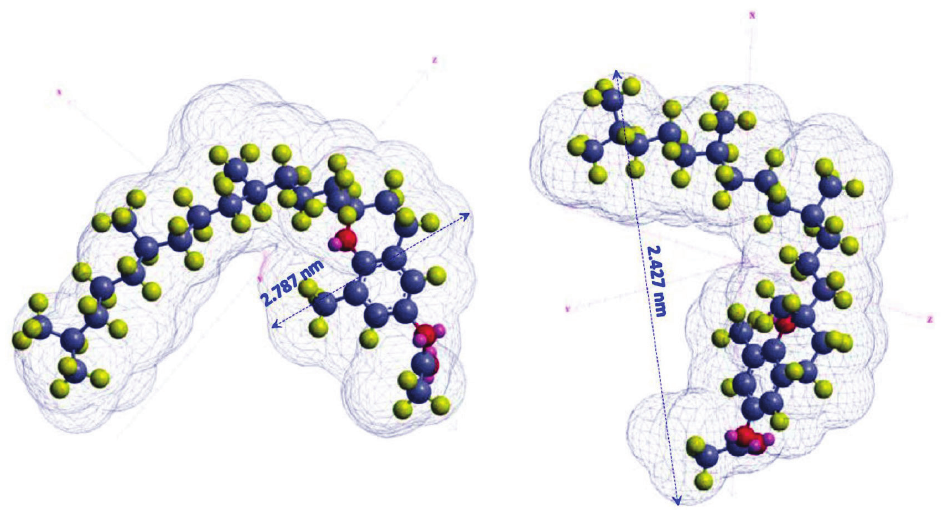
Fig. 7 – Connolly molecular area and molecular dimensions of vitamin E